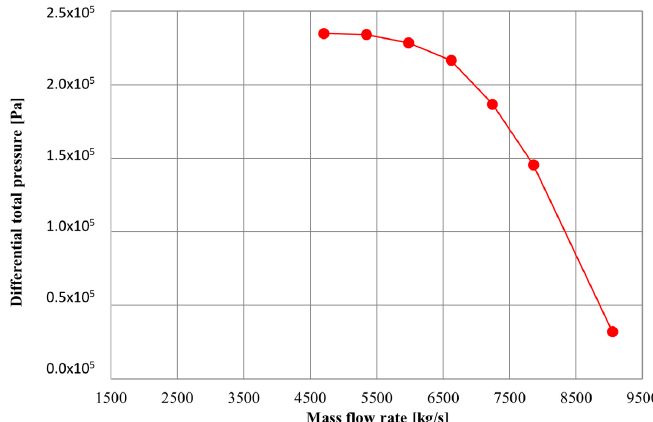
Figure 11. Optimal design of the Archimedean pump: differential total pressure as a function of the mass flow rate.